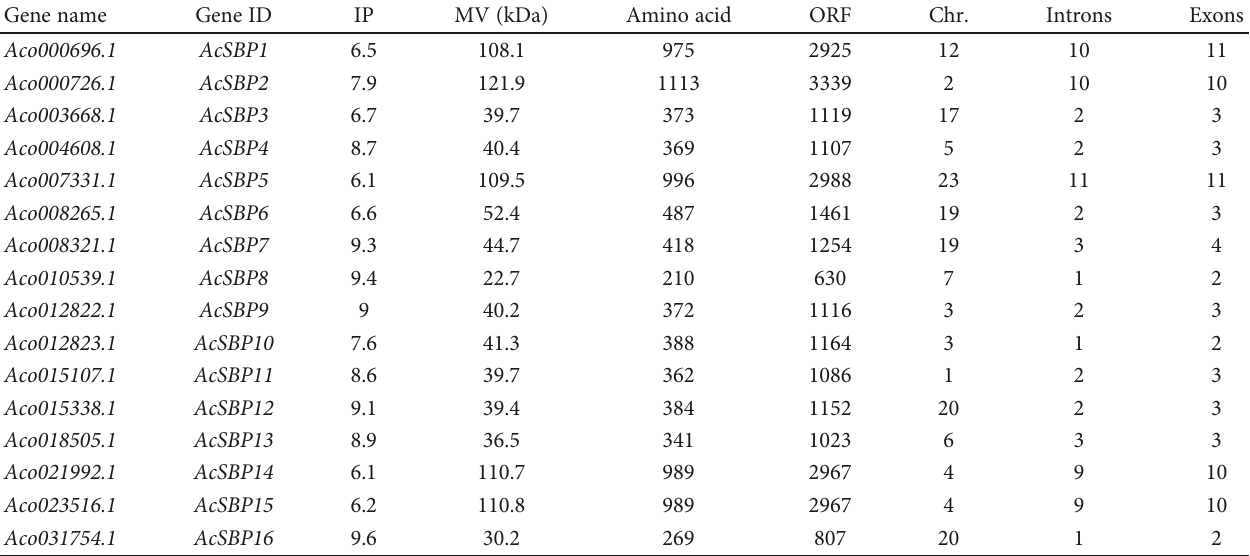
Table 1: Characterization of SQUAMOSA promoter-binding protein (SBP) gene family in